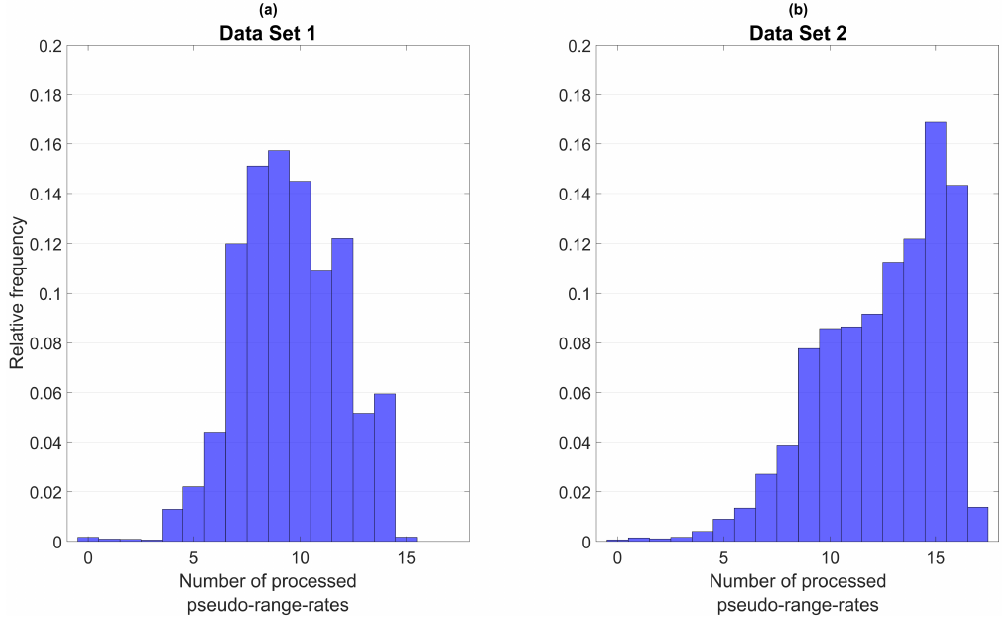
Figure 5. Relative frequency distribution for the number of processed pseudo-range-rates. Multi-frequency/multi-constellation algorithm. Table 7. Accuracy Metrics for Attitude (Roll; Pitch; Yaw) and Velocity (FLU and ENU